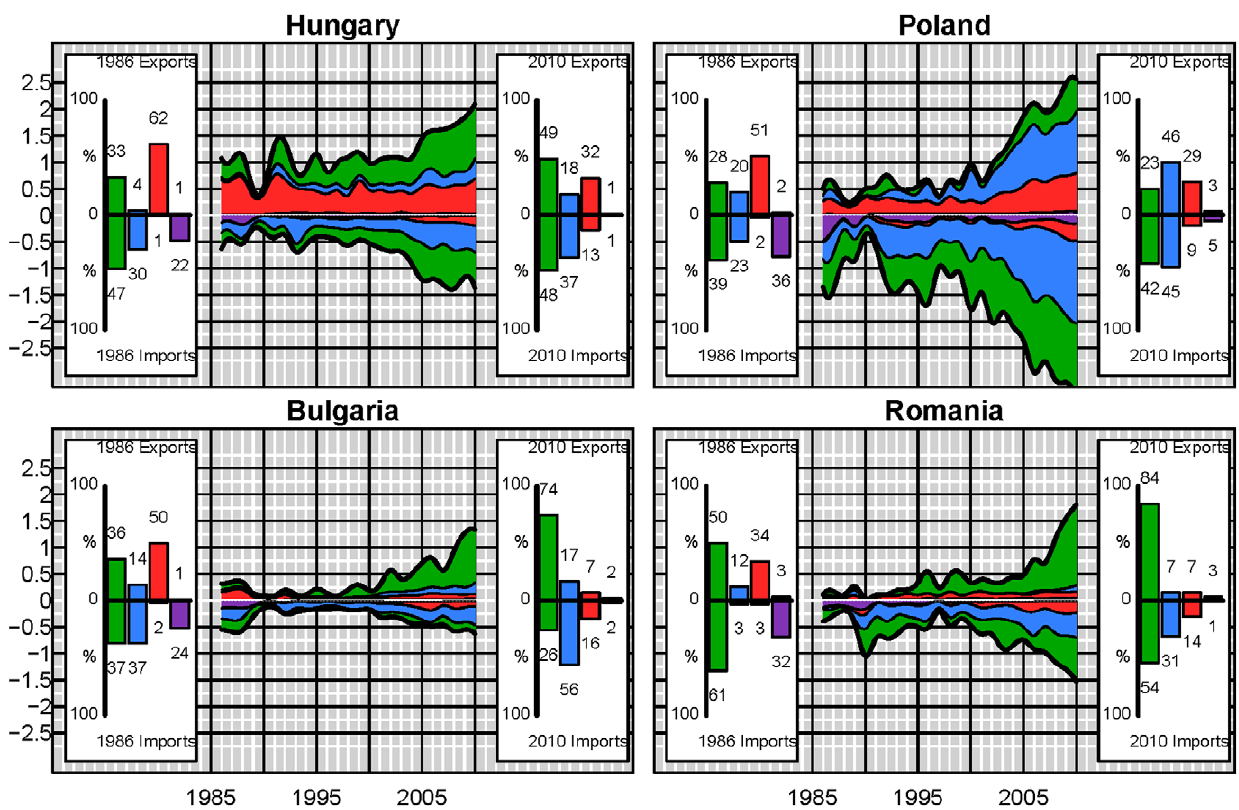
Figure 8. Detailed virtual water trade (10 10 m 3 ) by commodity type for Hungary, Poland, Bulgaria and combined former USSR and Russian federation. The insets indicate the percentage of virtual water imports or exports contributed by plant, animal, luxury and other